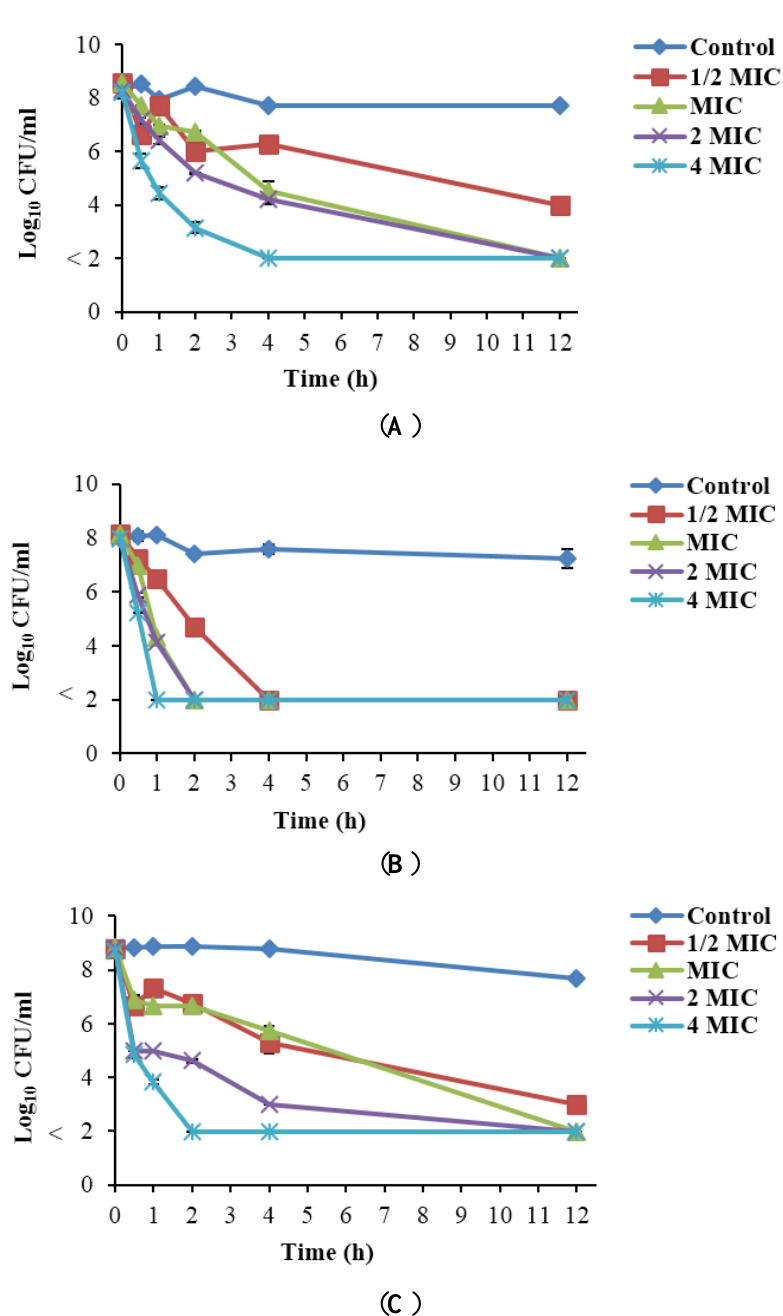
Figure 3. Inactivation of Listeria monocytogenes Scott A ( A ); FSL R2-574 ( B ); and PSU-KV-133 ( C ) using Rhodomyrtus tomentosa ethanolic leaf extract at various concentrations, as well as the control with 0.1% dimethyl sulfoxide. Cells in the stationary phase of growth were treated with the extract in sterile 0.85% normal saline solution and surviving cells were enumerated at time intervals. The detection limit was 10 2